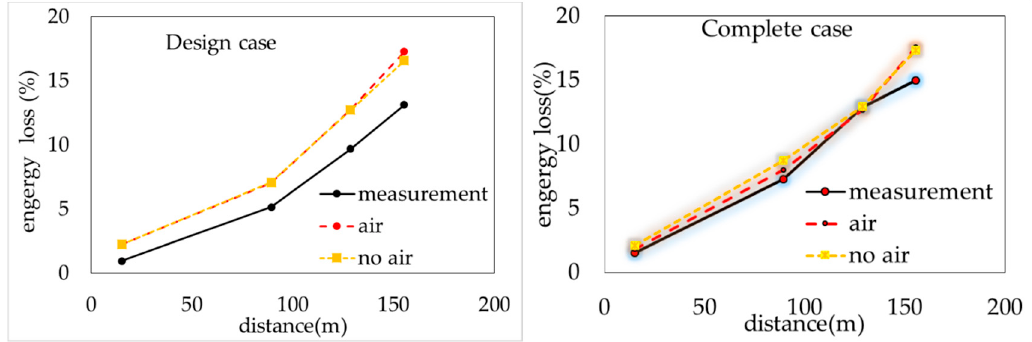
Figure 22. Energy loss along the spillway chute for the design case and complete case.